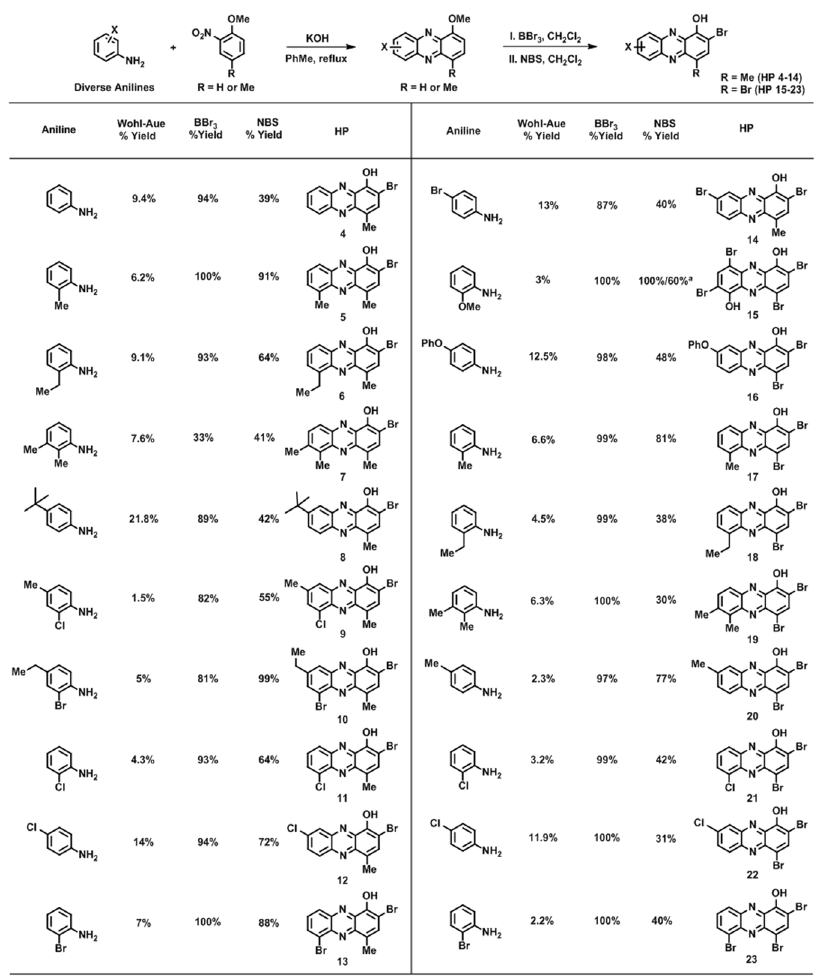
Figure 2. Chemical synthesis of a diverse panel of HPs using a convergent Wohl-Aue route. Note: 1,6-Dimethoxylphenazine (Wohl-Aue product) was dibrominated (NBS), then demethylated (BBr3) before final dibromination (NBS) to give HP 15. See Supporting Information for full synthesis